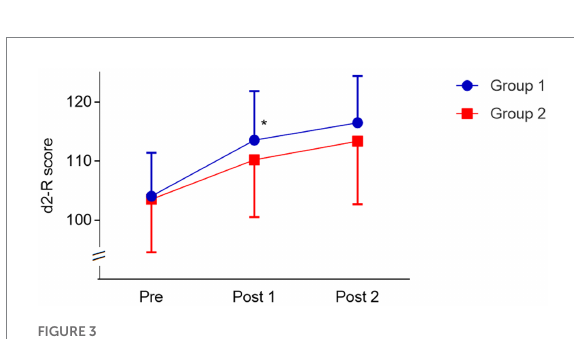
FIGURE 3 Change in d2-R score (Mean ± SD) of both groups (Group 1, PE First; Group 2, MI first) over time. Significant interaction (* p < 0.05) between time and group with higher score for Group 1 at Post